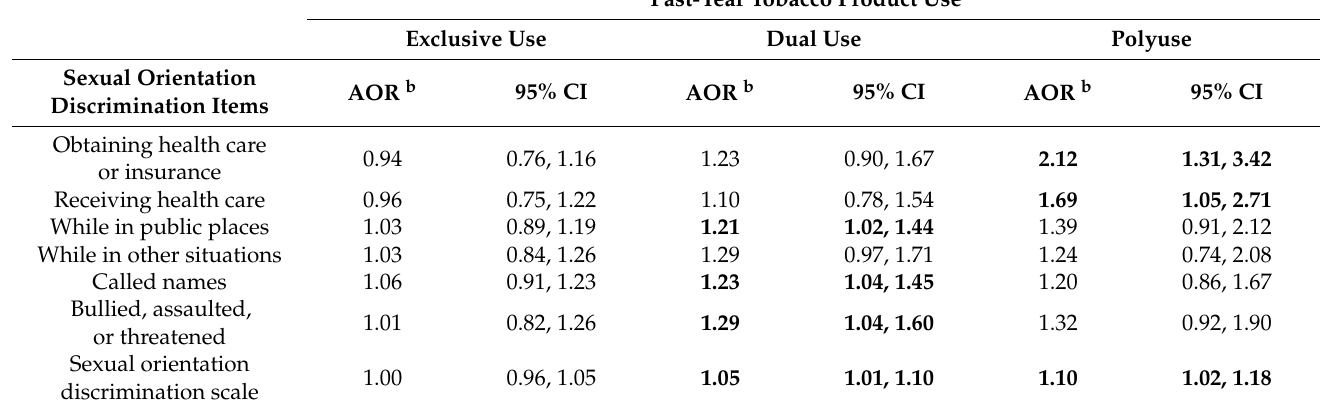
Table 3. Multivariable Multinomial Logistic Regression Models of Associations Between Prior-to- Past-Year Experiences of Sexual Orientation Discrimination and Past-Year Exclusive, Dual, and Polytobacco Use ( n =